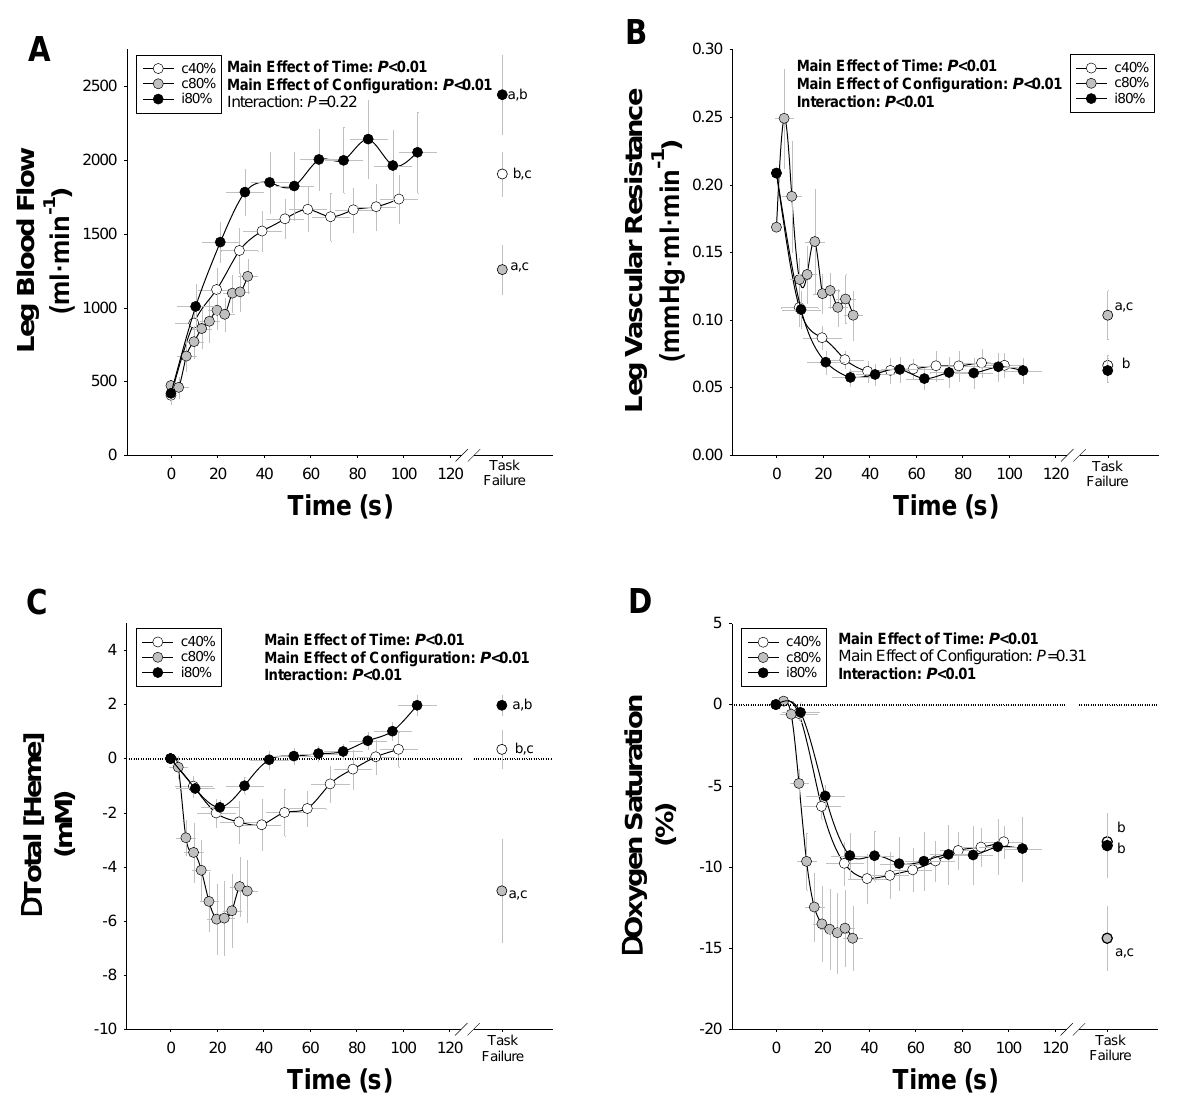
Figure 5. Impact of Interrepetition Rest on Hemodynamics during Heavy Single-Leg Knee Extension Resistance Exercise Performed to Task Failure. ( A ) Leg blood flow through the femoral artery, ( B ) leg vascular resistance, ( C ) the change from rest in the total concentration of heme ([Heme]) of the exercising thigh and ( D ) the change in oxygen saturation of heme in the exercising thigh during knee extension performed continuously at 40% (c40%) and 80% (c80%) of one-repetition max (1RM), as well as intermittently with 2 s of interrepetition rest at 80% (i80%) 1RM. a: significantly different than the c40% trial; b: significantly different than the c80% trial; c: significantly different than the i80% trial.